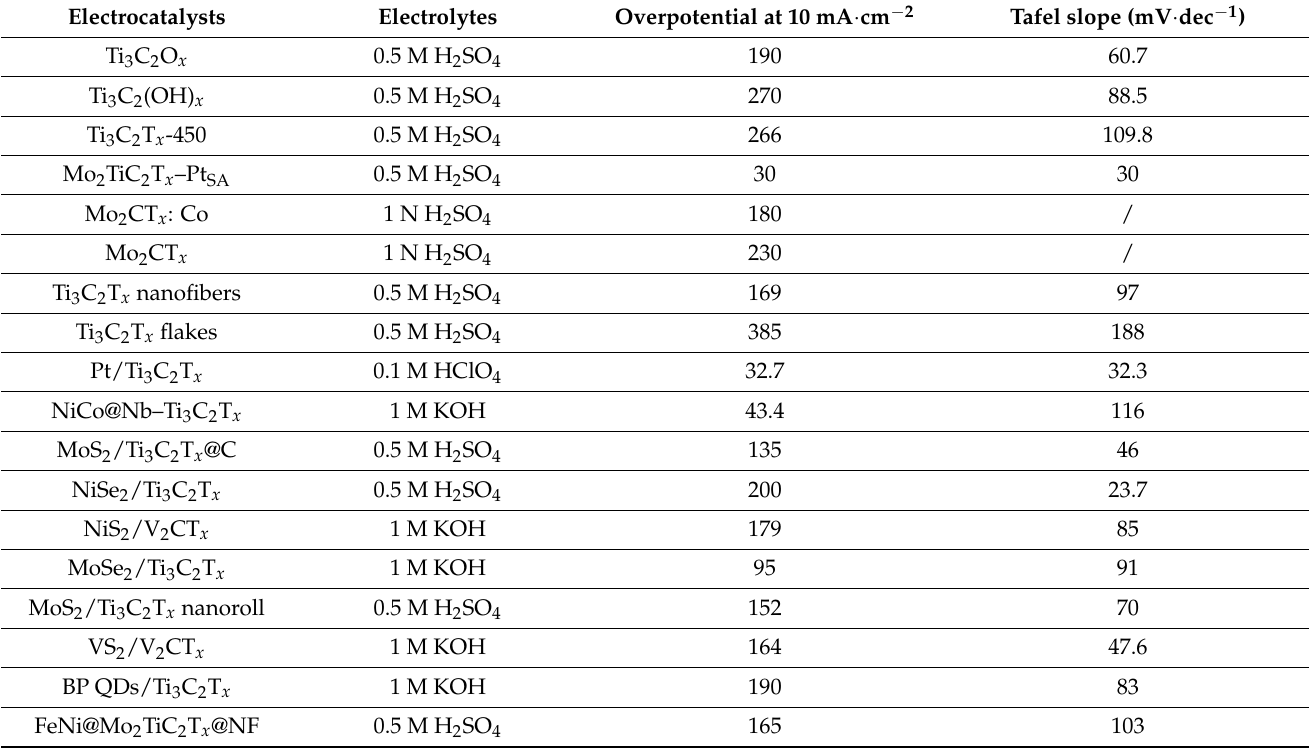
Table 4. Summary of the HER performances of MXene-based electrocatalysts [139]. Electrocatalysts